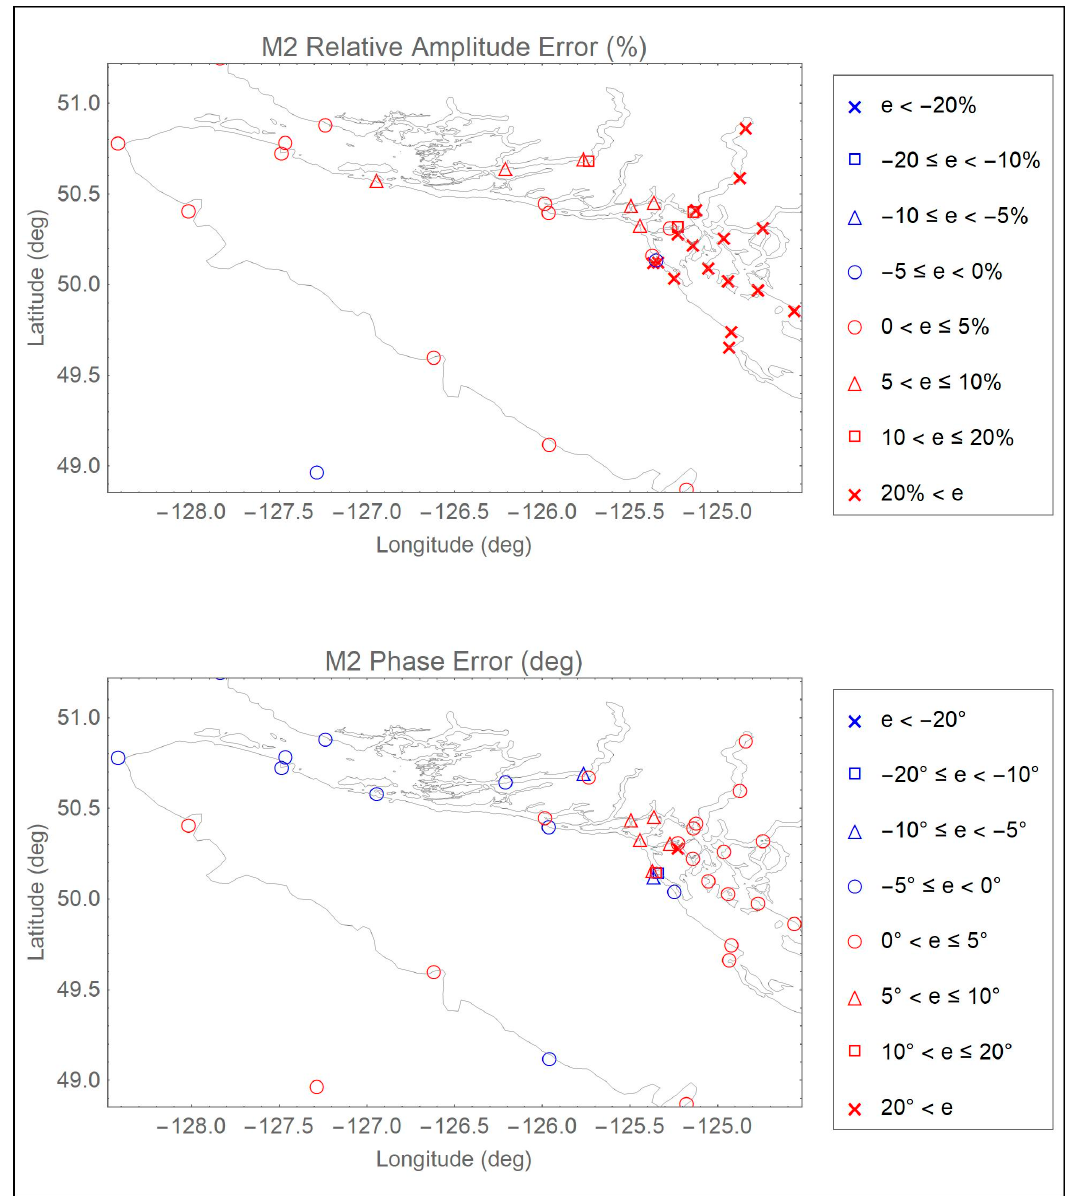
Figure A21. Distribution of ENPAC15 relative amplitude (%) and absolute phase (deg) errors for the M 2 constituent: British Columbia coast view.